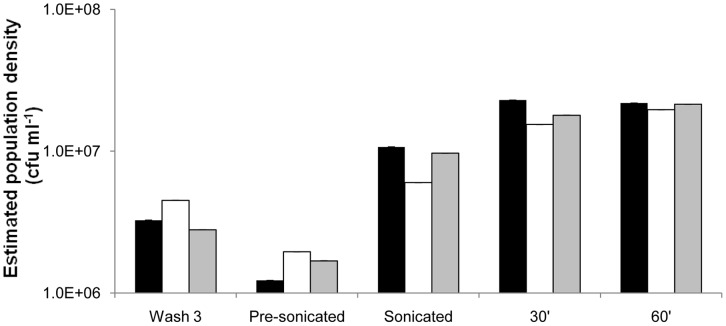
Mean viable cell densities of bacteria released from the walls of the culture vessels following 6 days of daily dosing with ciprofloxacin (black), daptomycin (white) and gentamicin (shaded).
Wash 3 - densities of bacteria in PBS following the third wash. Pre-sonicated - densities of bacteria in MHII added to the vessels immediately prior to sonication but after washing. Sonicated - densities of these cultures in MHII after 5 minutes of sonication. 30′ and 60′ – respectively, densities estimated in MHII 30 and 60 minutes after MHII addition and sonication. Three independent estimates of densities were made for each sample. All standard errors were less than 0.1% of their respective means.